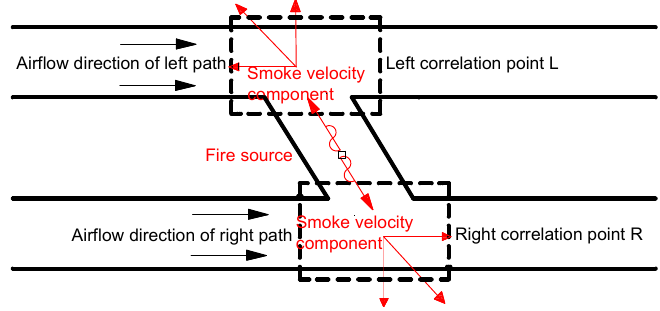
Figure 13. Velocity diagram of left and right correlation points.